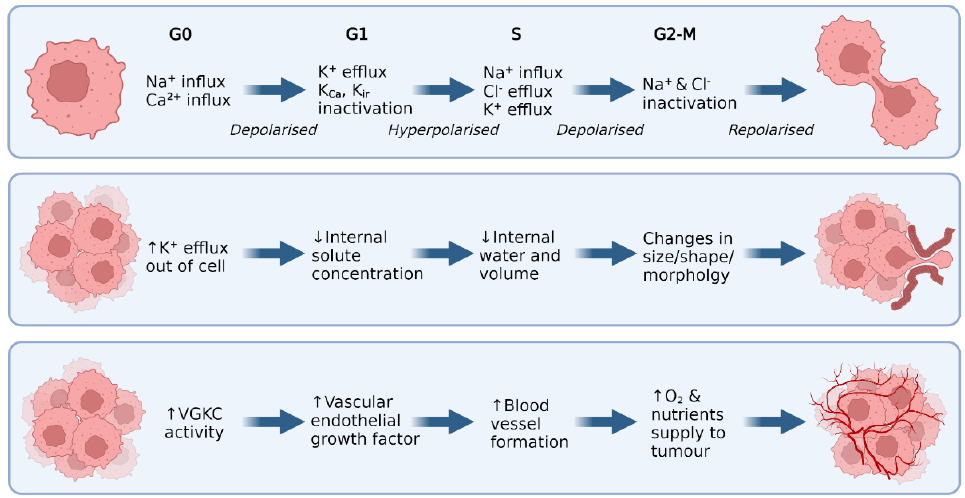
Figure 2. Potassium channels are involved in key cancer hallmarks in malignant cells. Top panel: To initiate the cell cycle (G0/G1) an influx of Na + and Ca 2+ occurs, depolarising the cell. In G1, VGKCs, K ir , and K Ca channels activate and pump K + ions out of the cell, hyperpolarising the cell. Towards the end of G1, all K + channels are inactivated, and the cell is pushed into S phase. Here, Na + is pumped into the cell, and Cl - and K + are pumped out. The now depolarised cell enters G2/M, where Na + and Cl - channels are inactivated, the cell is repolarised, and mitosis occurs. Middle panel: Malignant cells undergo K+ efflux to facilitate the water loss required to alter size and shape. This allows cancer cells to navigate tight extracellular spaces and invade tissue such as the brain parenchyma. Bottom panel: VGKCs, such as K v 10.1, can induce VEGF secretion, thus stimulating the formation of vasculature to feed the growing tumour. ↑ : Indicates a relative increase; ↓ : Indicates a relative decrease.